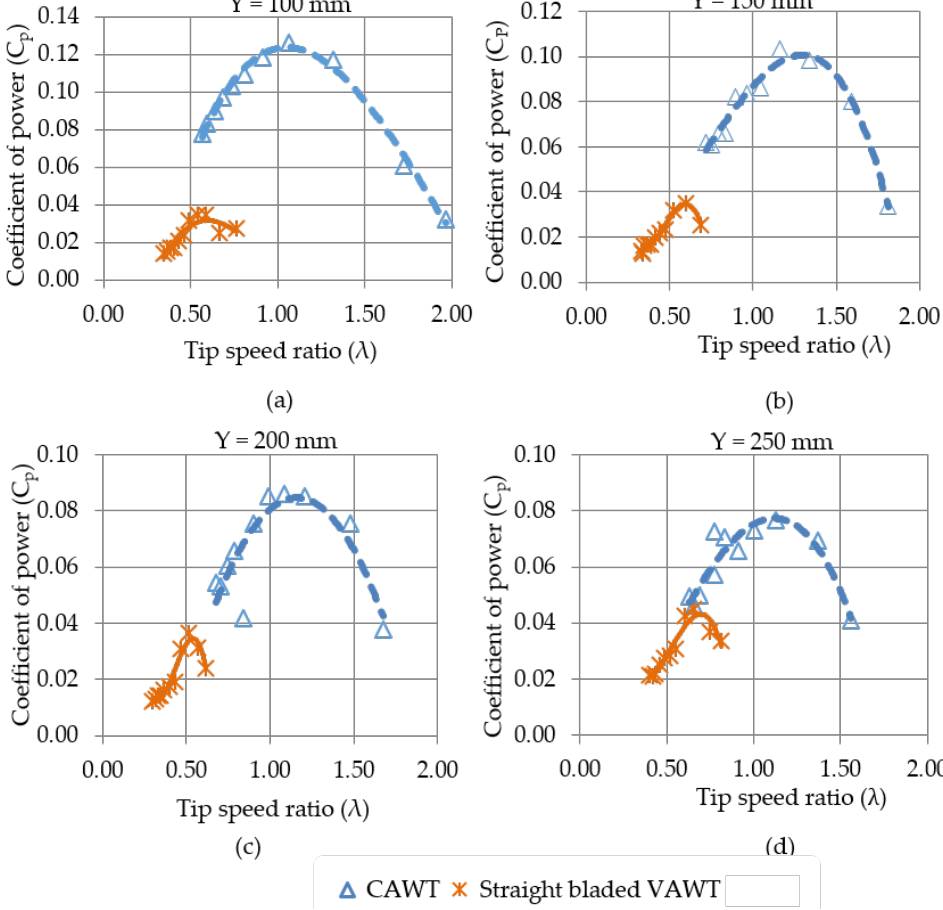
Figure 12. Coefficient of power against tip speed ratio for CAWT and straight-bladed VAWT for height above the rooftop: ( a ) Y = 100 mm; ( b ) Y = 150 mm; ( c ) Y = 200 mm; and ( d ) Y = 250 mm.